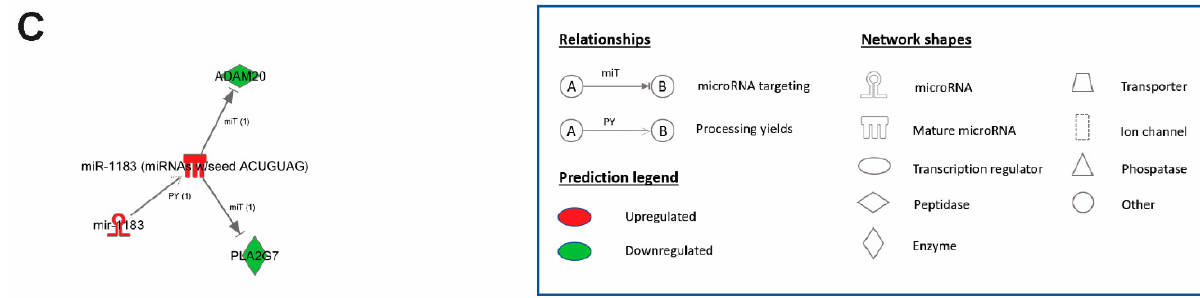
Figure 5 . MicroRNA–mRNA network displaying the direct regulation of target genes by miR-1183. Up-regulation of miR-1183 and down-regulation of target genes following ( A ) tachycardia and ( B ) stretch. ( C ) Commonly regulated miR-1183 and target genes ADAM20 and PLA2G7 . Ingenuity